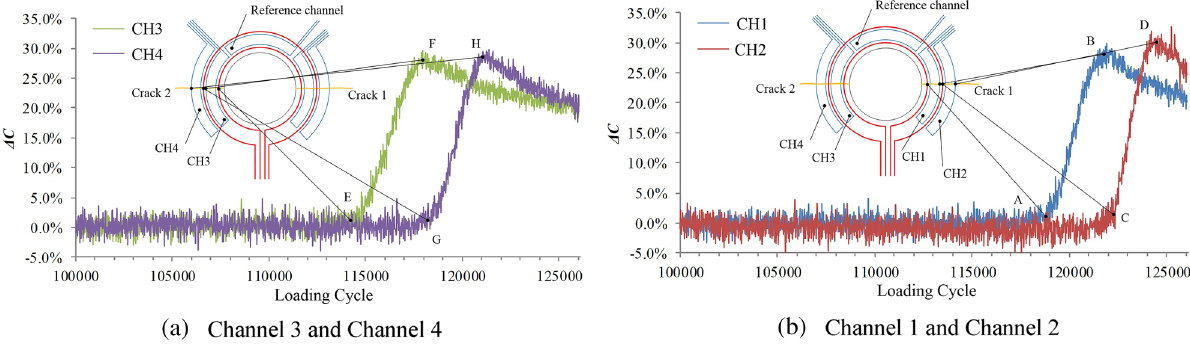
Figure 22. Relationship between sensor output signal and number of load cycles.